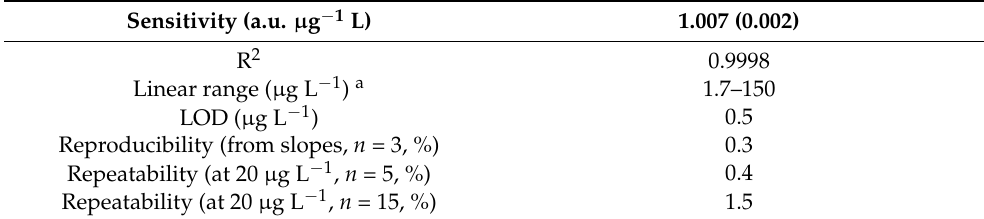
Table 1. Calibration data for the Ni(II) determination on SPCE at ammonium/ammonia buffer pH 9.2 applying an E d of − 0.7 V and a t d of 120 s. Standard deviations are denoted by parenthesis.